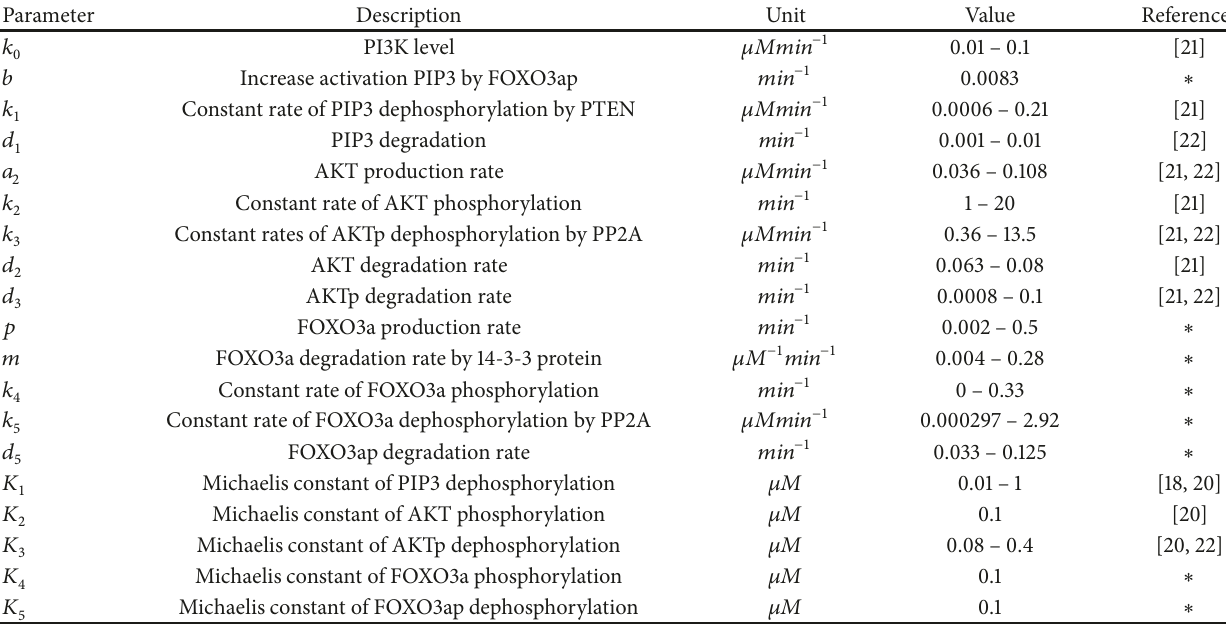
Table 2: Parameter values and kinetic rates being